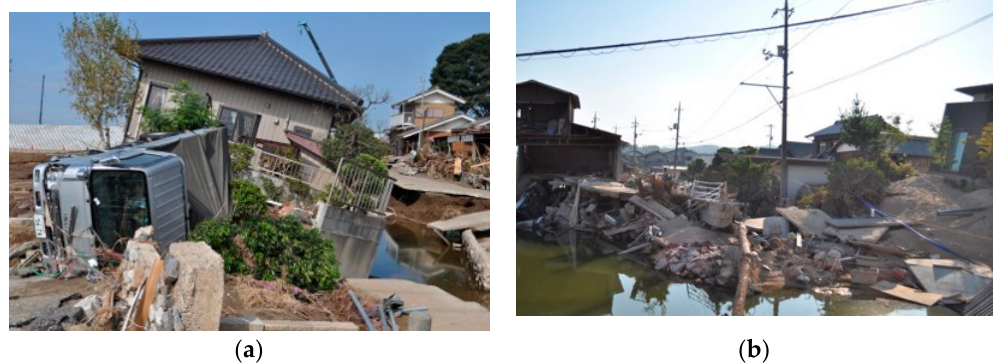
Figure 1. Damage to houses and properties near river banks or break points caused by large-scale flooding. ( a ) Joso City at the height of the 2015 Kanto Tohoku heavy rainfall; ( b ) Mabi-cho, Kurashiki City during the 2018 western Japan heavy rainfall.